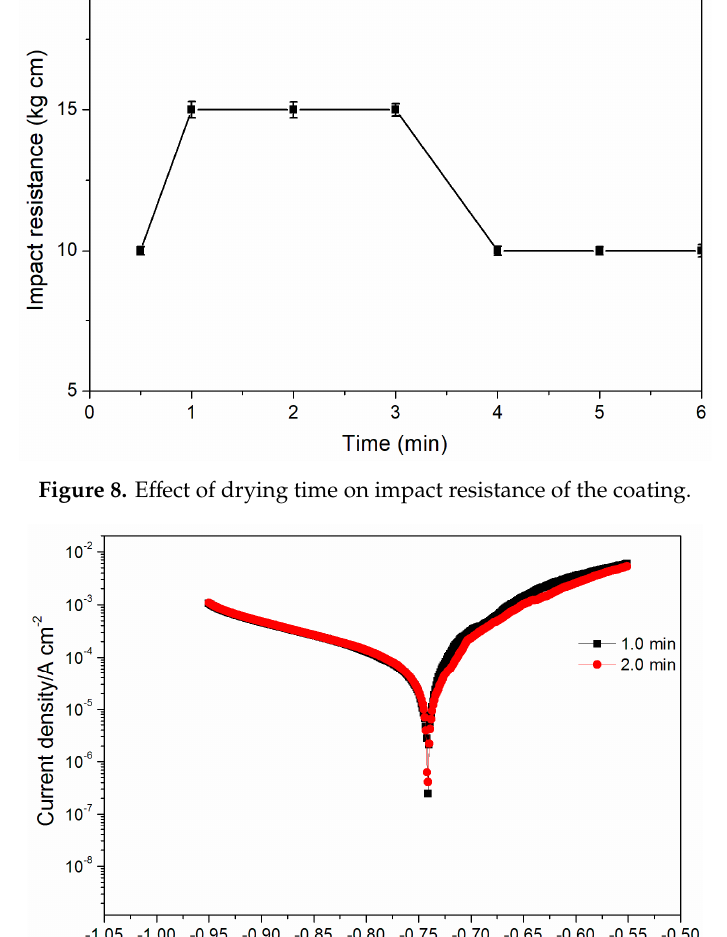
Table 7. Effect of drying time on corrosion resistance of the coating.